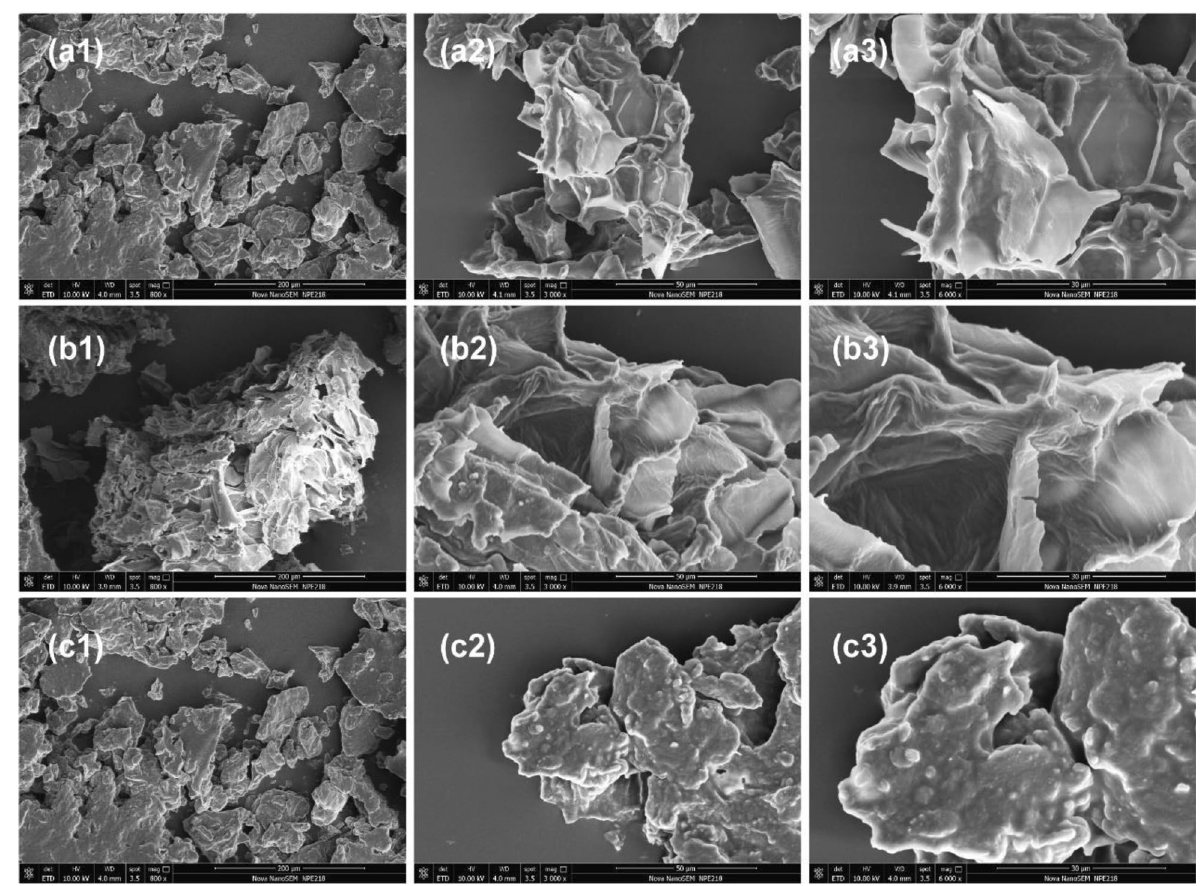
Fig. 3 SEM images of okara samples, either untreated dry okara ( a1 , a2 , a3 ) or treated using cellulase ( b1 , b2 , b3 ) and cellulase β-glucosidase pectinase ( c1 , c2 , c3 ). The magnification and scale bars are provided in each + +